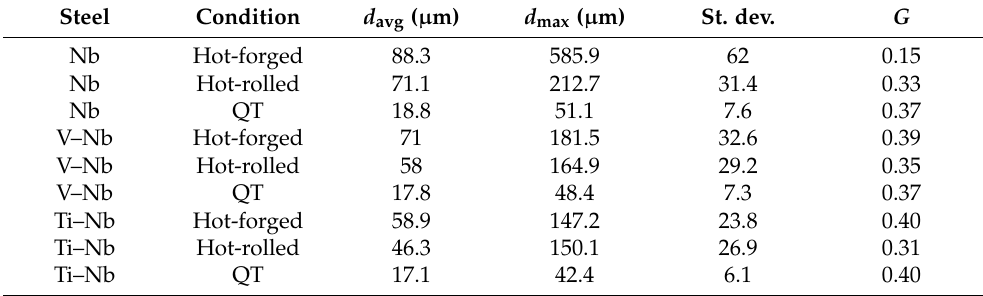
Table 2. Average ( d avg ) and maximum ( d max ) grain size, standard deviation (St. dev.) and distribution factor ( G ) for hot-forged, hot-rolled and QT condition for steel Nb, V–Nb and Ti–Nb.